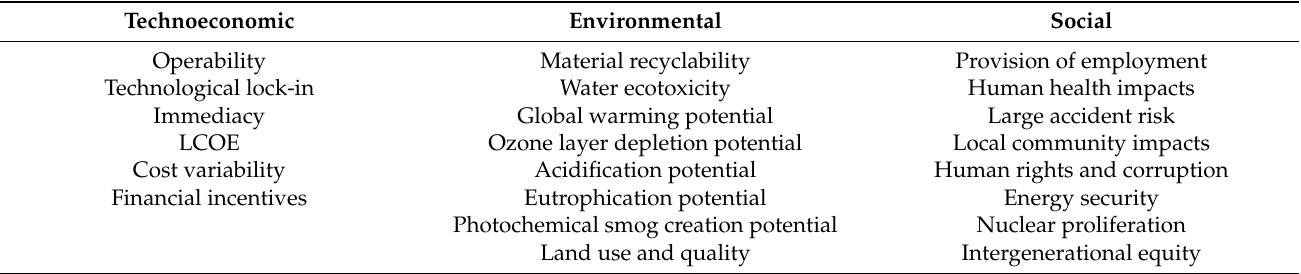
Table 1. Categories of sustainability indicators proposed by Stamford and Azapagic [25] for energy